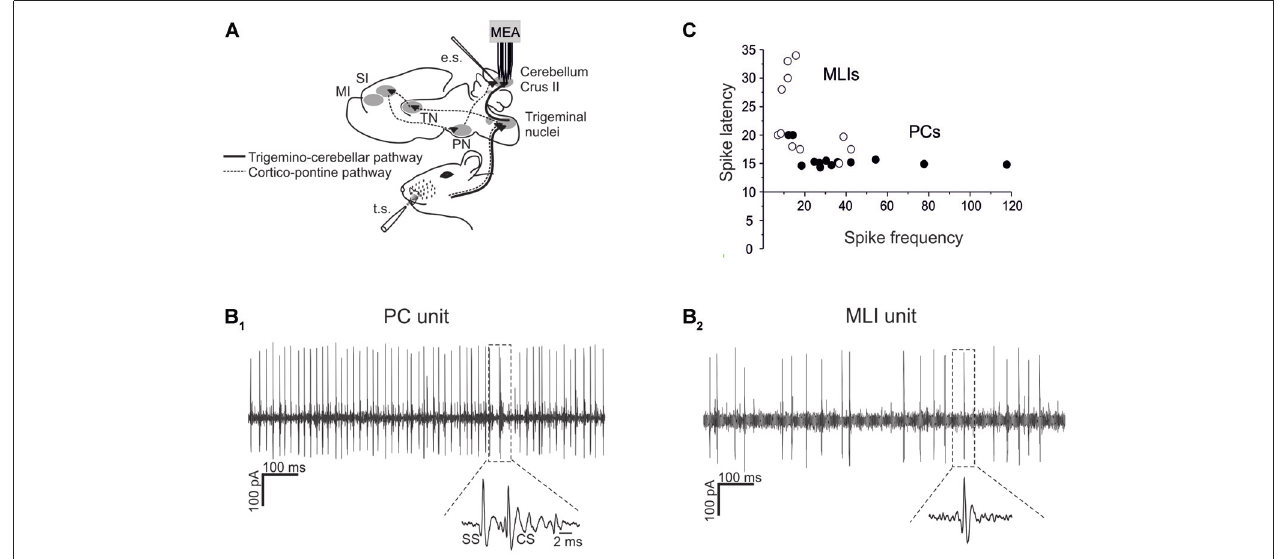
FIGURE 1 | Single-unit recordings from PCs and MLIs. (A) Schematic representation of recording set-up. PC and MLI units were recorded from cerebellar Crus I and II in urethane anesthetized rats using a 16-channel multi-electrode array. Tactile stimulation (TS) was performed by delivering air puffs to the whisker pad and peri-oral area. Electrical stimulation (ES) of PFs was performed with a bi-polar tungsten electrode. The pathways involved in the transmission of sensory stimulation to the cerebellar cortex are shown, including the faster trigemino-cerebellar pathway and the slower thalamo-cortico-pontine pathway. (B 1 ,B 2 ) Sample spike trains recorded from a PC and an MLI are shown. In (B 1 ) a PC unit shows relatively fast and regular SS firing with a CS followed by a SS pause (zoomed in the inset). In (B 2 ) an MLI unit shows relatively less regular and slower firing compared to SS firing in the PC. (C) Spike delays (taken from PSTH as in Figure 2 ) are plotted against basal firing frequency. PCs usually show a higher firing frequency and a shorter spike latency than